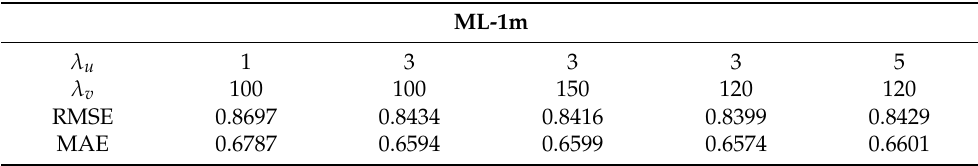
Table 4. Influence of λ u and λ v on RMSE and MAE on